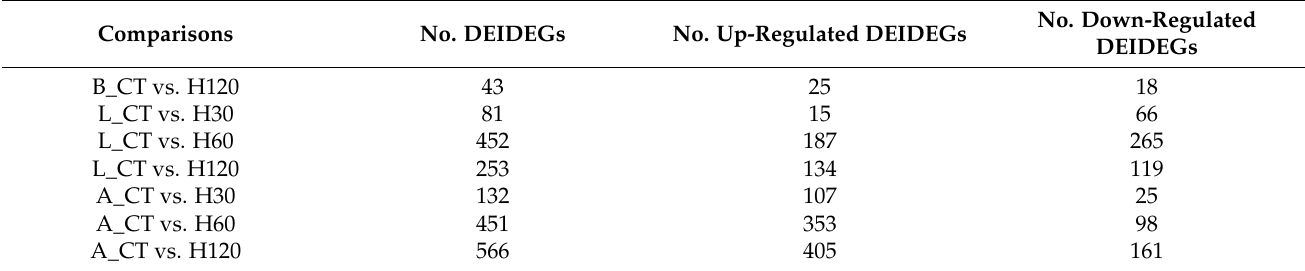
Table 5. Summary of differential isoform-corresponding genes that were also differentially expressed (DEIDEGs).